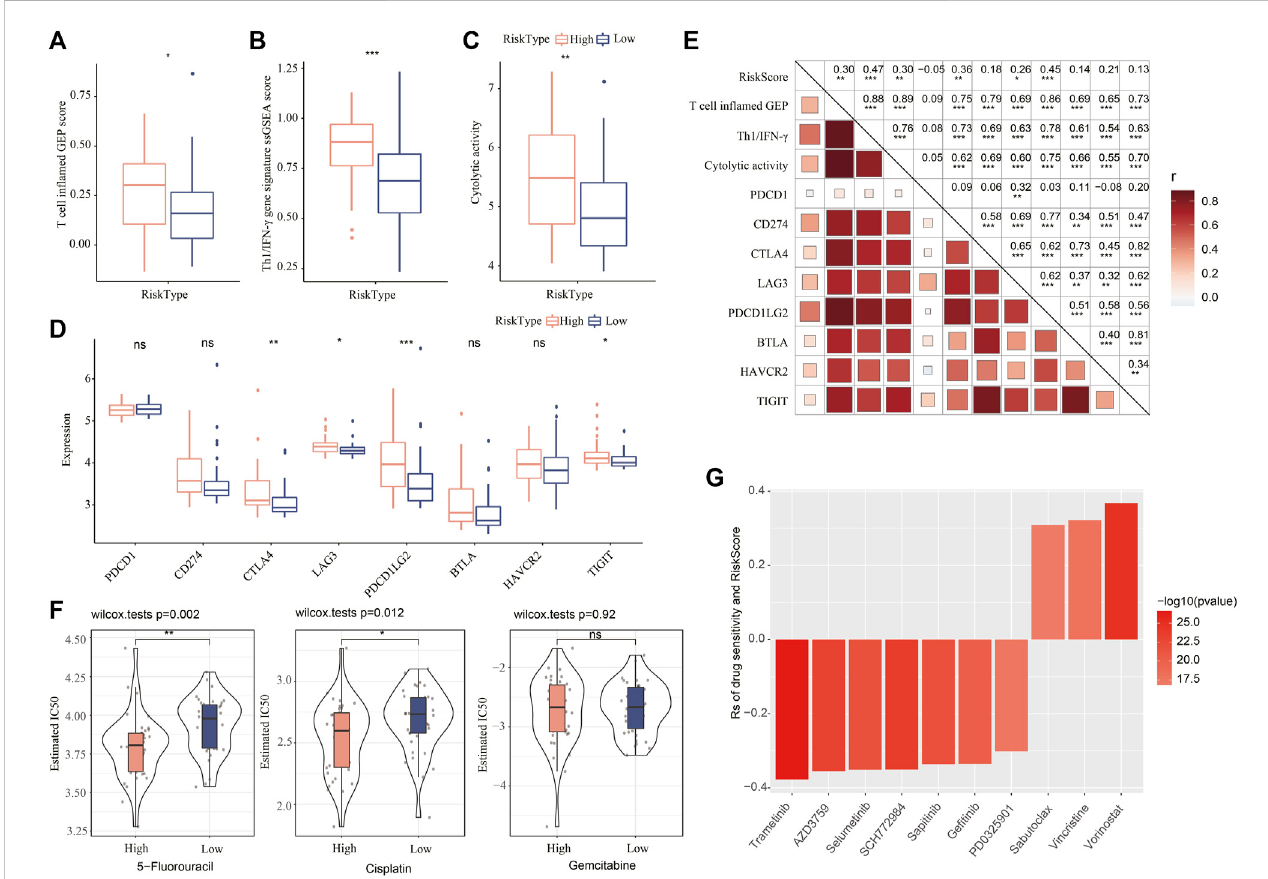
FIGURE 7 Validating the value of the risk model in predicting the response to clinical therapy. (A – C) The ssGSEA score of T cell in fl amed GEP, Th1/IFN- γ , and cytolytic activity in two risk groups. Wilcoxon test was performed. (D) The expression of key immune checkpoints in two risk groups. Wilcoxon test was performed. (E) Pearson correlationanalysis of riskscore withimmunesignaturesand immune checkpoints. (F) The estimated IC50of5- fl uorouracil,cisplatin, and gemcitabine in two risk groups. (G) Spearman correlation analysis between drug sensitivity and risk score. Rs indicates correlation coef fi